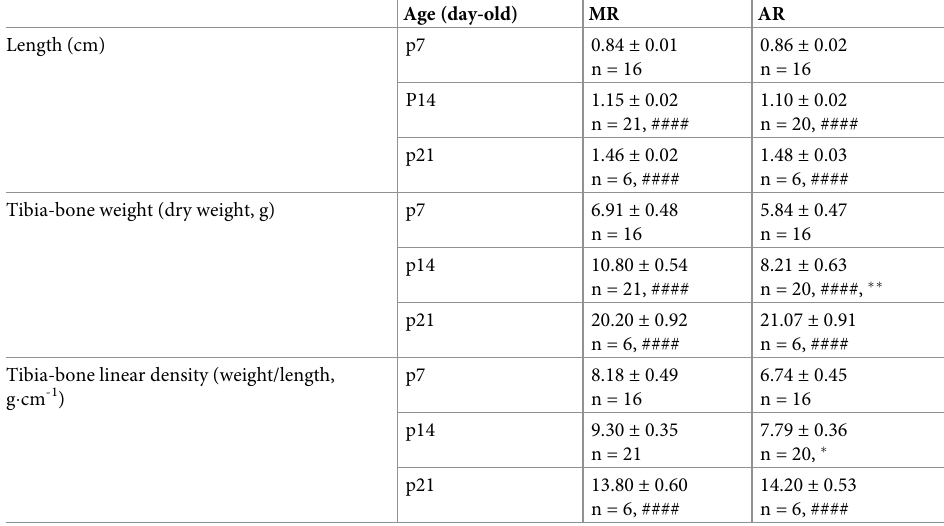
The right tibial bone was obtained from the pups: at pnd7, MR and AR n = 16; at pnd14, MR and AR n = 21,